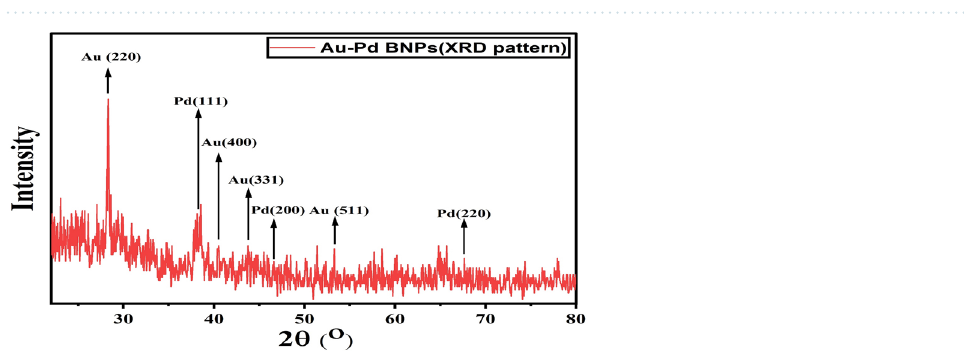
Figure 3. EDX Analysis for original sample of the synthesized 2 mM Au–Pd BNPs using the 10% aqueous leaf extract of Ctirus limon [Inset showing A) SEM micrograph of Au–Pd BNPs, and the EDX table for elements analysis results].